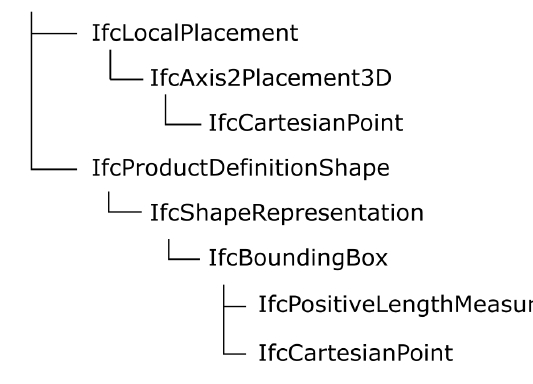
Figure 7. Our IFC annotation structure.